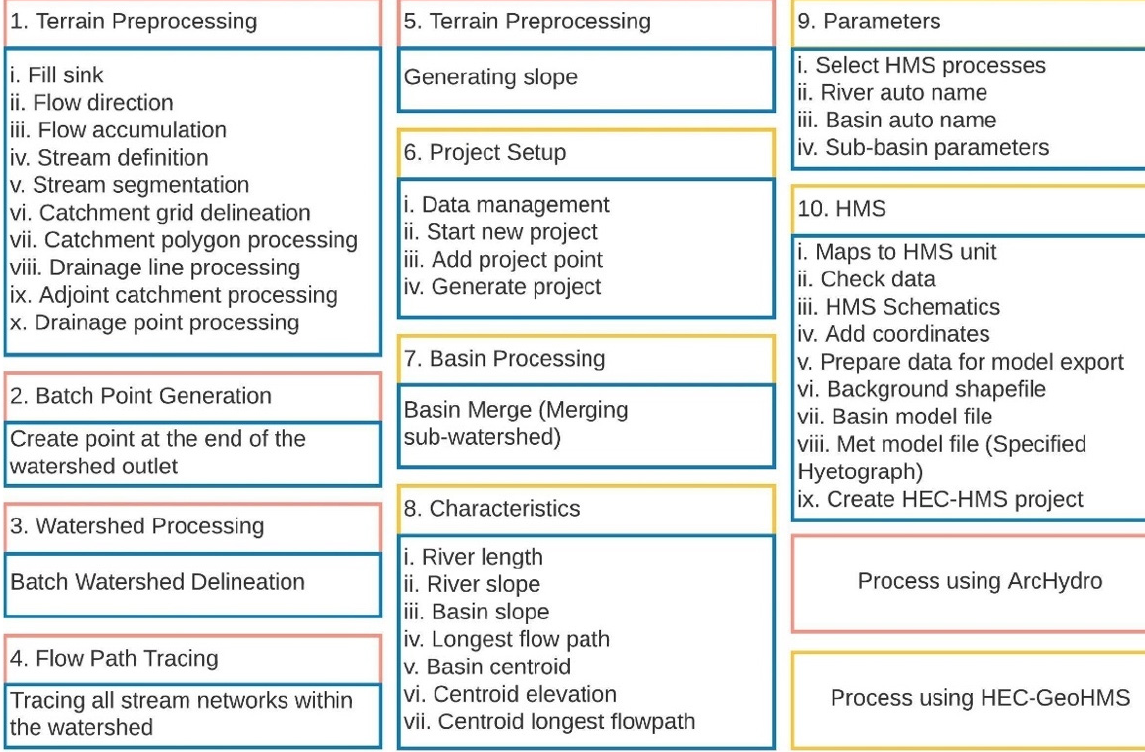
Figure 7. The summarised steps for generating the base model in sequences. Steps 1 to 5 were performed using ArcHydro (pink-blue rectangle), while Steps 6 to 10 were conducted with HEC-GeoHMS (yellow-blue rectangle).